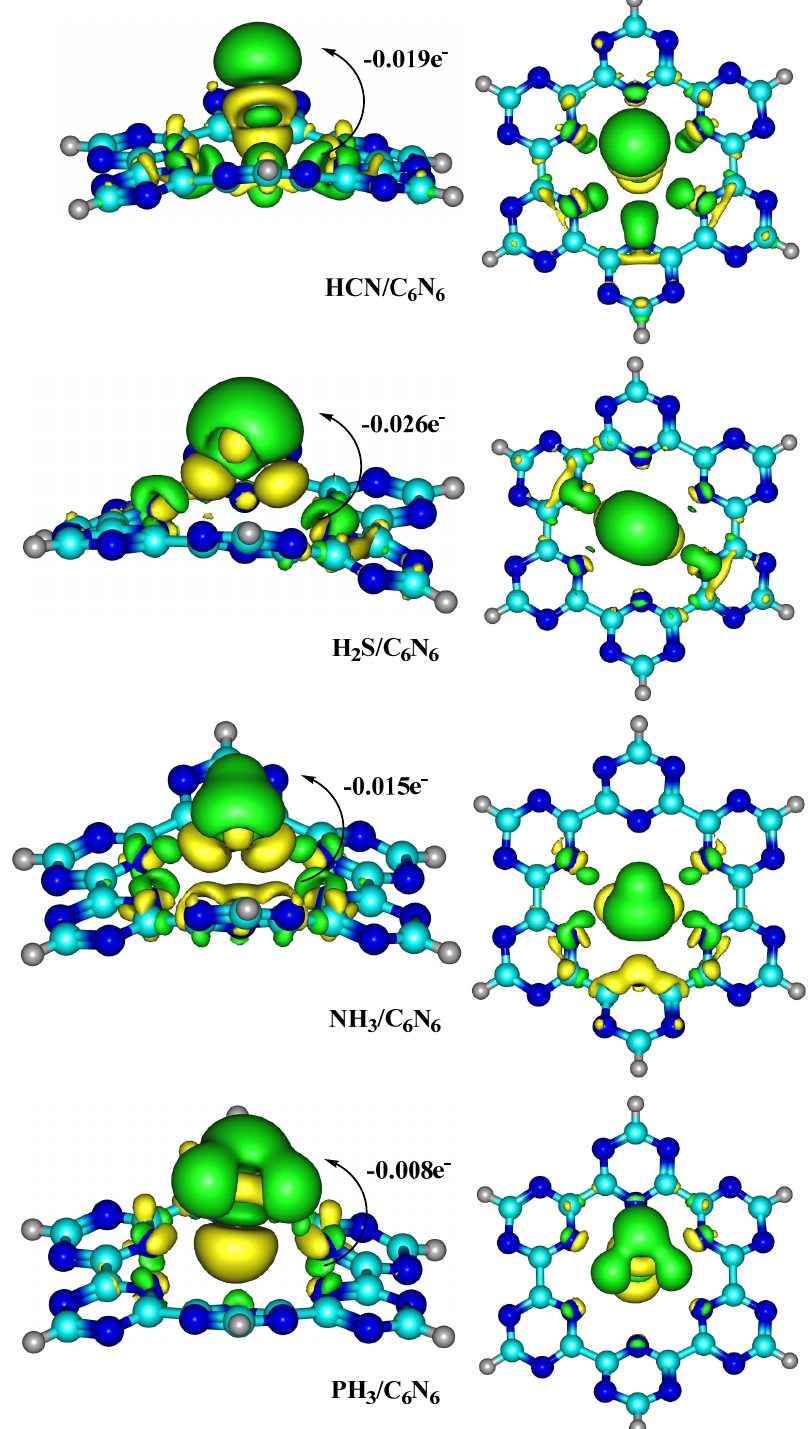
Figure 6. The topologies of analyte@C 6 N 6 complexes determined through EDD analysis Figure 6 . The topologies of analyte@C 6 N 6 complexes determined through EDD analysis (Isovalue = 0.0019 a.u.). (Isovalue = 0.0019